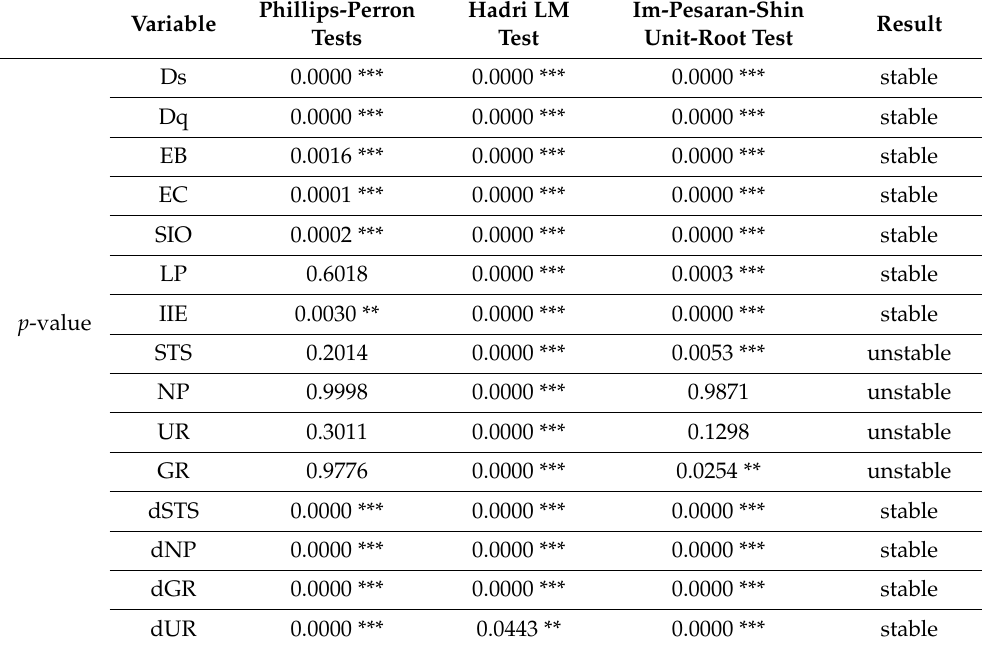
Table 3. Robustness test.